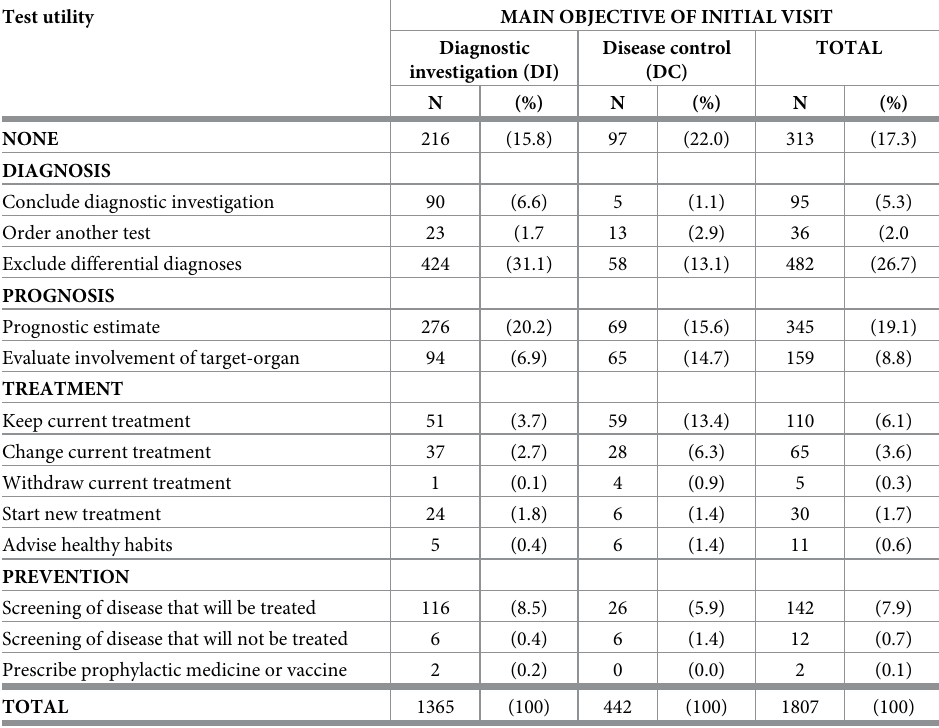
Table 2. Tests ordered and categorized after follow-up, according to the main objective of initial visit.